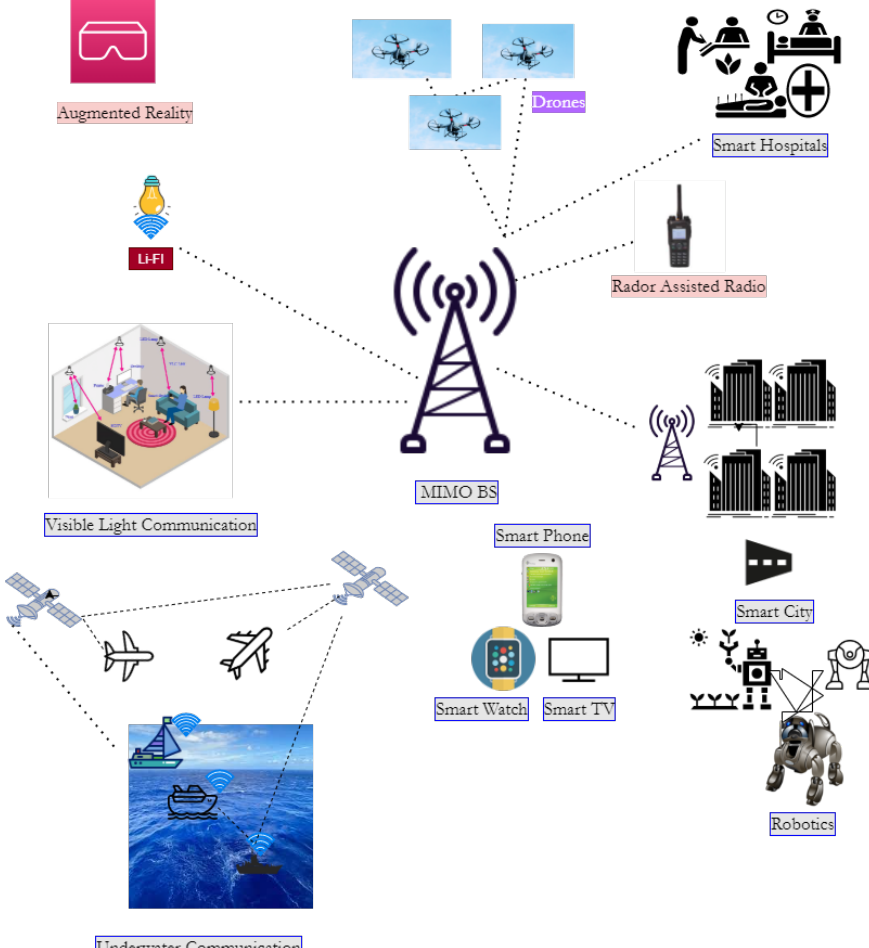
Figure 1. Communication paradigm for IoE